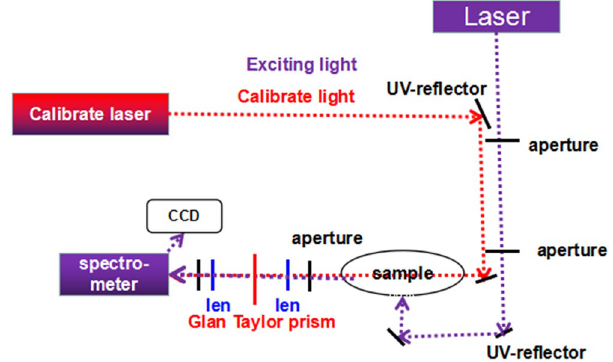
Figure 2. The polarization photoluminescence experimental light path